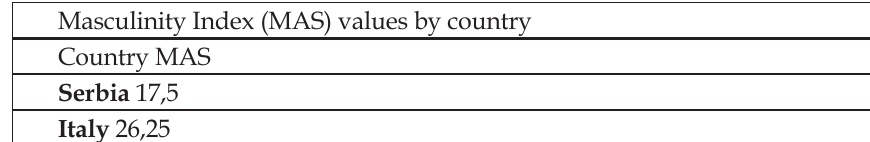
Table 5. Masculinity Index (MAS) values by country.